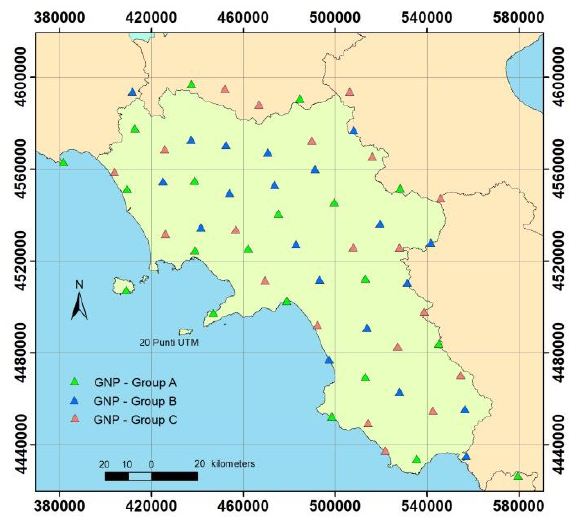
Figure 1. The localisation of the all 60 GNPs used as GCPs for adapting EGM2008 on the Campania Region and generating local geoid models.